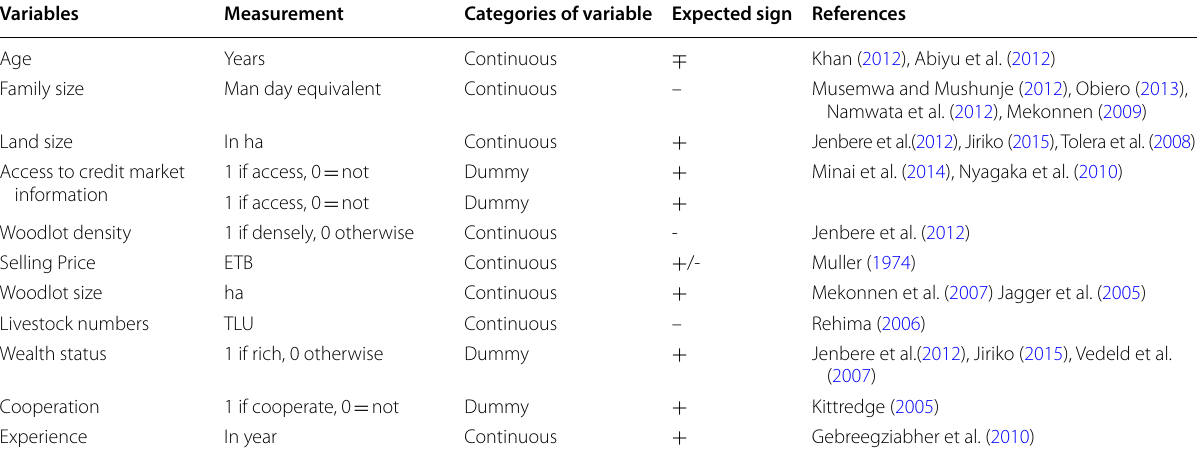
Table 1 Summary of explanatory variables used in OLS model Variables